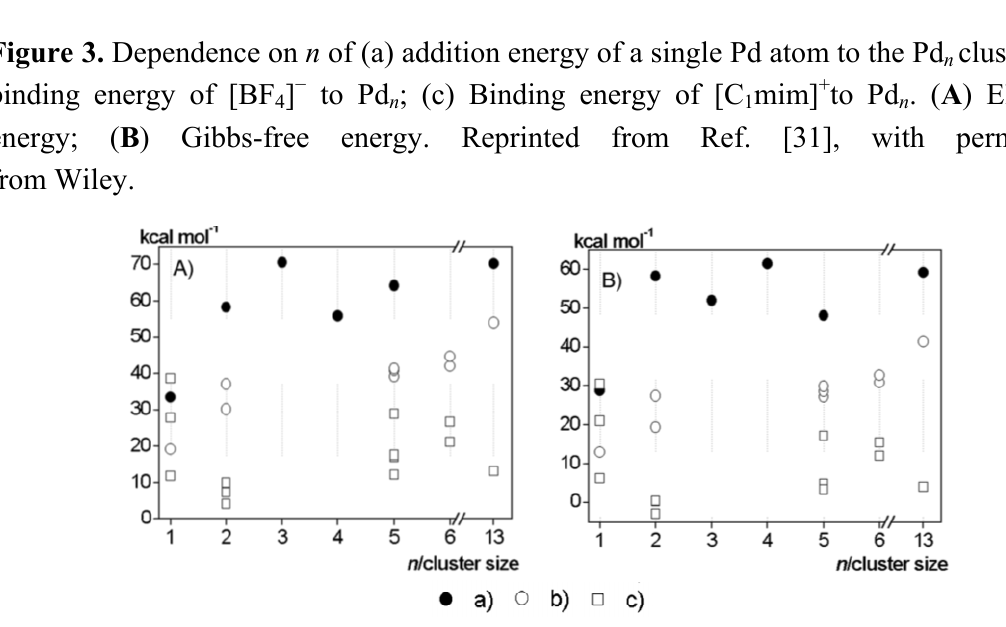
cluster; (b) n mim] + to Pd . ( A ) Electron 1 n